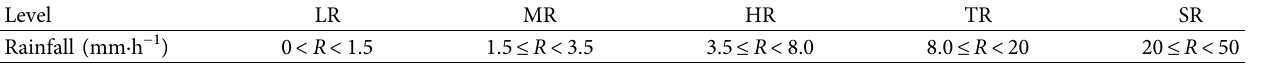
Table 2: Grade classification of rainfall intensity.